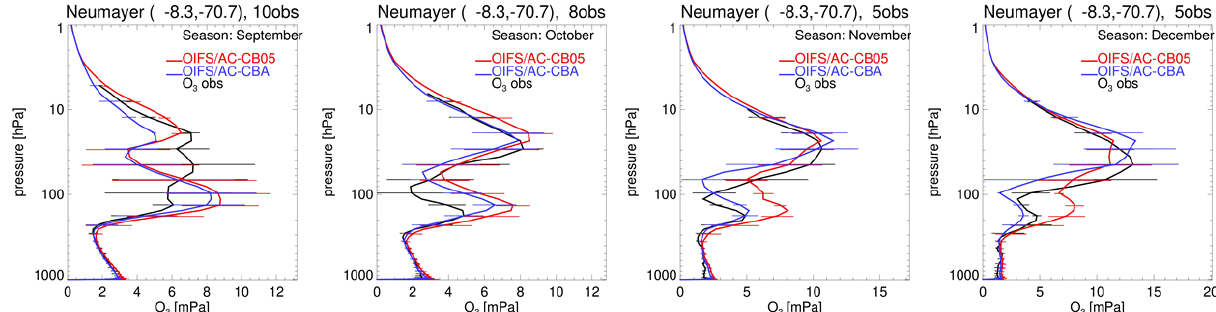
Figure 5. Evaluation of OpenIFS/AC stratospheric O 3 against sondes (black lines) during September–December 2010 at Neumayer Station (8.3 ◦ W, 70.7 ◦ S), showing the OpenIFS/AC-CB05 (red lines) and the OpenIFS/AC-CBA (blue lines) configurations. Error bars represent 1 σ variability during this period.